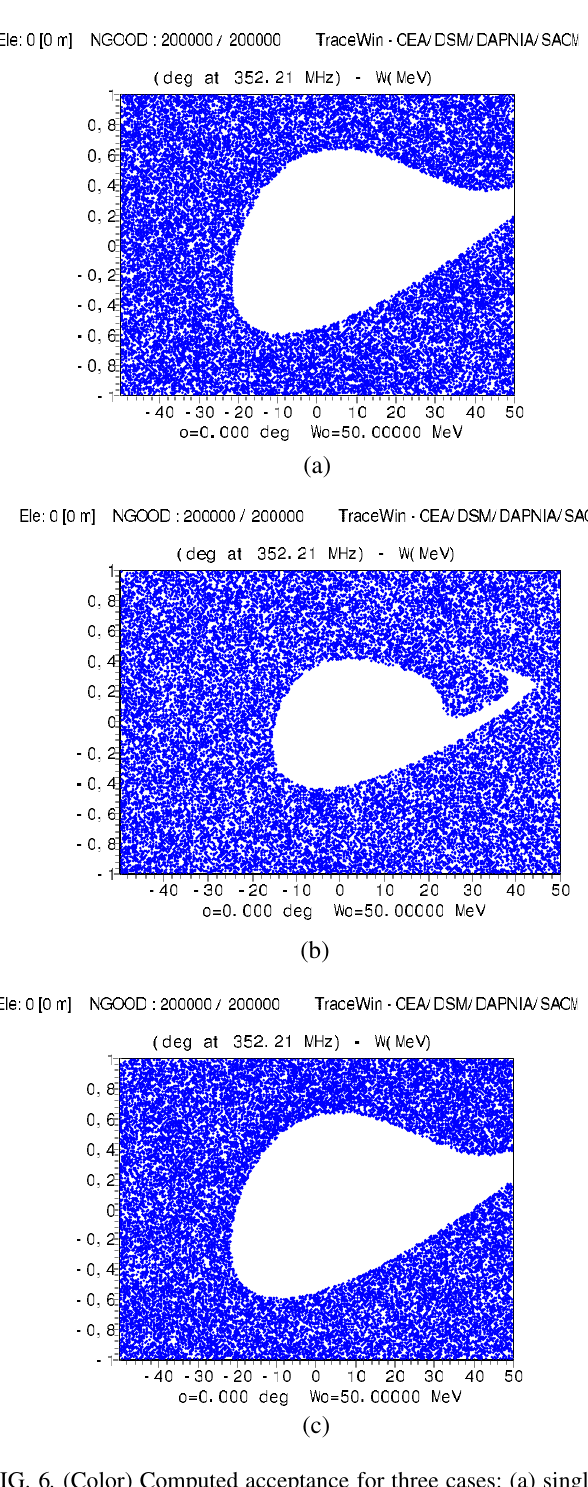
FIG. 6. (Color) Computed acceptance for three cases: (a) single frequency, (b) frequency jump with a matching at transition, (c) frequency jump the mix